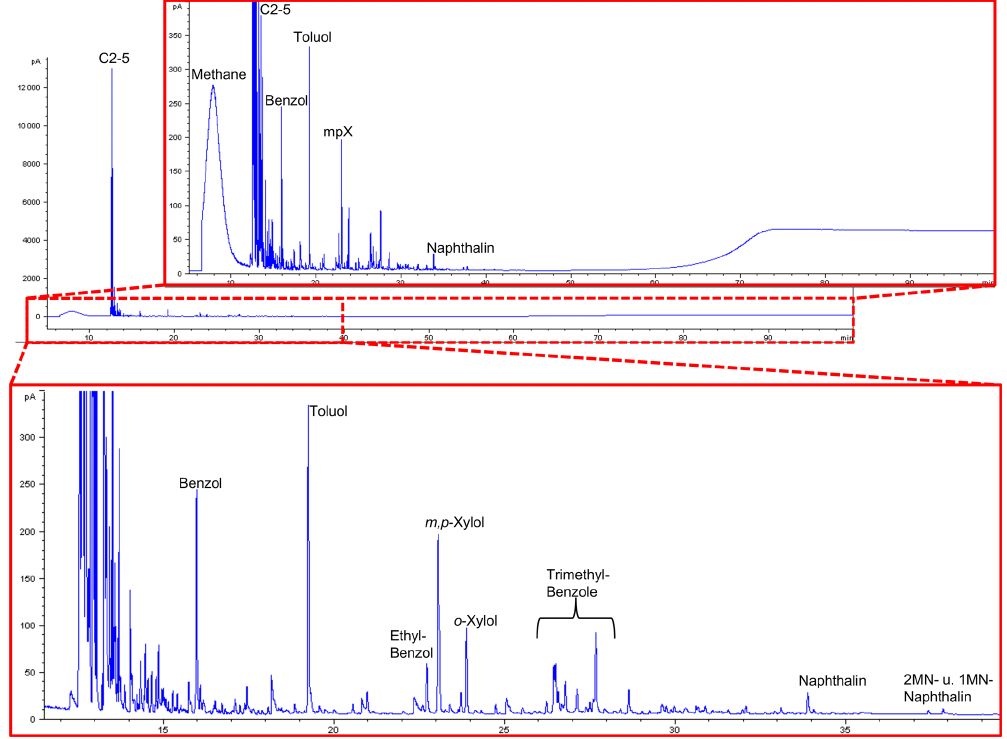
Figure 13. GC traces from open-system pyrolysis of kerite (sample #0/Museum Ac. Sci. Kiev) are dominated by the hydrocarbon gases methane through pentane and subordinately by alkylated mono- and diaromatic compounds, typical breakdown products of mature or very mature OM. Table 2. Results of Pb isotope data of aliquots of OM: sample #9 (visually pure oxykerite) and sample #1 (impure with whitish minerals; RSD signifies relative standard